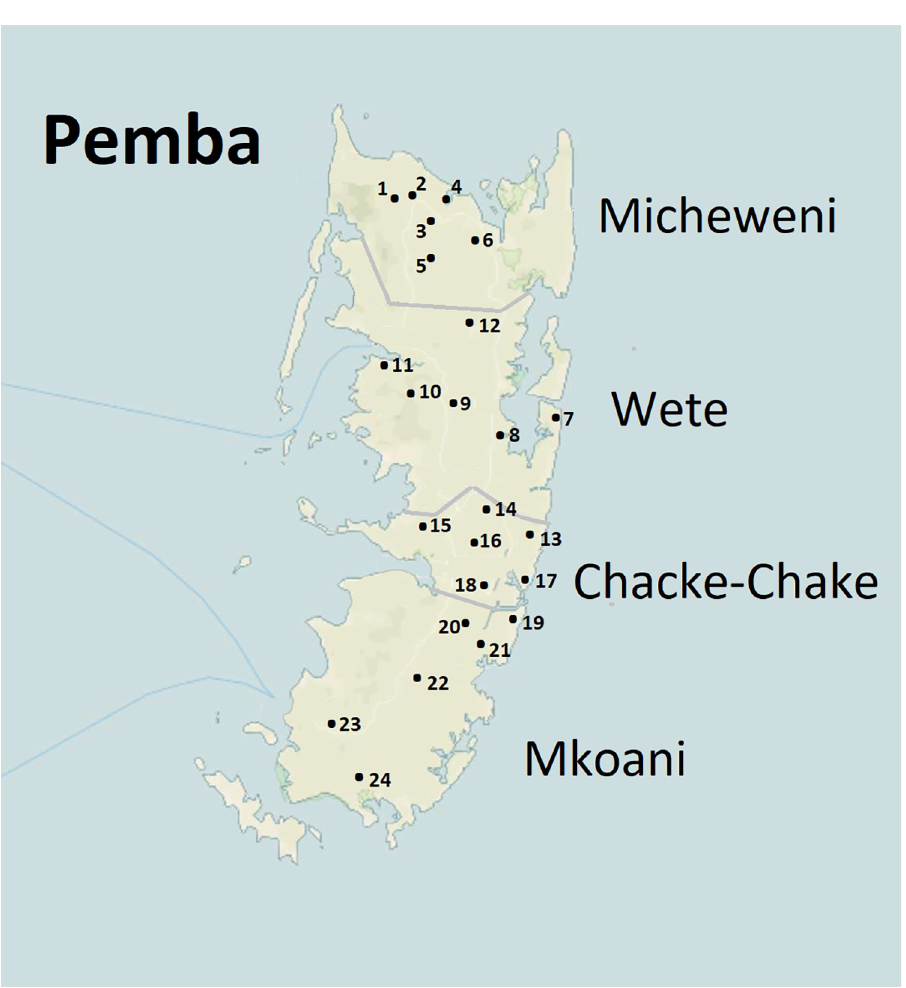
Fig 1. Location of the 21 primary schools in the sample the number correspond to the school number in Table 2. Base map in public domain from U.S. Geological Survey (USGS) via TopoView (https://ngmdb.usgs.gov/topoview/ viewer/#10/-5.2079/39.9923), a tool created by the National Geologic Map Database Project (NGMDB) with a basemap from OpenStreetMap.